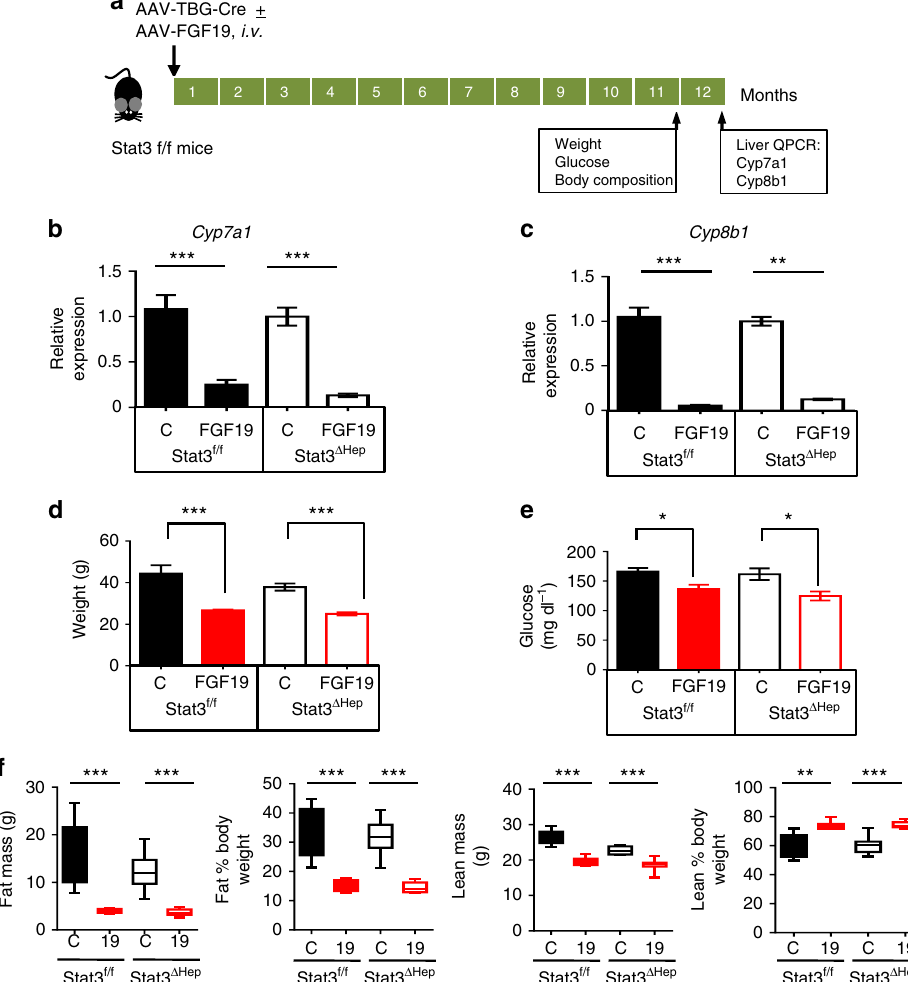
Figure 2 | Loss of STAT3 in hepatocytes does not impair FGF19-dependent metabolic improvements. ( a ) Study design. 14 to 18 week-old Stat3 f/f mice received a single tail vein injection of AAV- FGF19 ( n ¼ 8), or a combination of AAV- FGF19 and AAV-TBG-Cre ( n ¼ 8), or a control (C) virus ( n ¼ 5). Mice were killed 12 months after AAV administration to determine expression of Cyp7a1 and Cyp8b1 in the liver. Body weight, blood glucose, and body composition were measured 1 month before euthanasia. ( b ) Hepatic Cyp7a1 mRNA levels. Data are normalized to housekeeping gene GAPDH, and are relative to the expression in Stat3 f/f control mice. ( c ) Hepatic Cyp8b1 mRNA levels. ( d – f ) Body weight ( d ), plasma glucose ( e ) and body